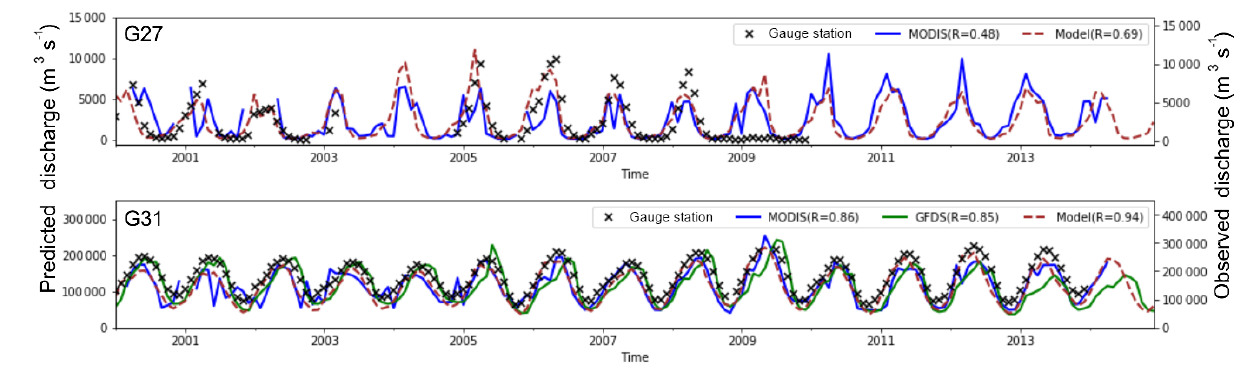
Figure 6. Comparisons between observations (right axis) from gauging stations (black x) and river discharge estimates (left axis) derived using MODIS SGRs (blue line), GFDS SGRs (green line), and the W3 model (brown